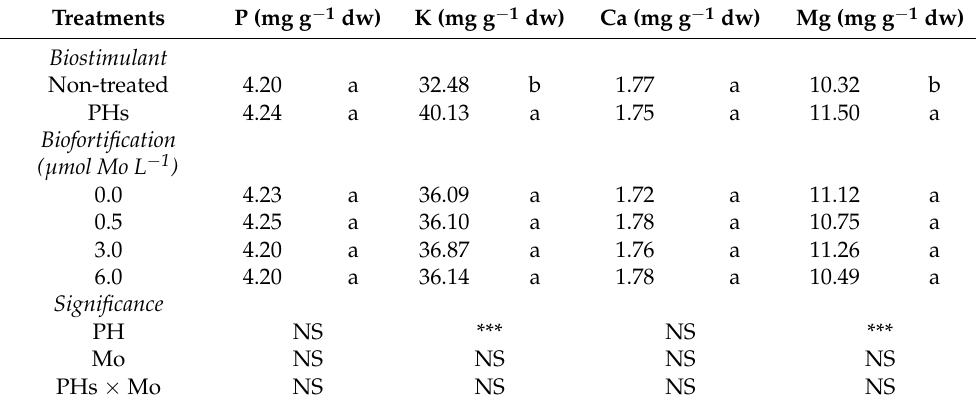
Table 2. Effect of PHs treatment and Mo-biofortification on phosphorous (P), potassium (K), calcium (Ca) and magnesium (Mg) concentrations of ‘Canasta’ lettuce leaves grown in a protected environment.